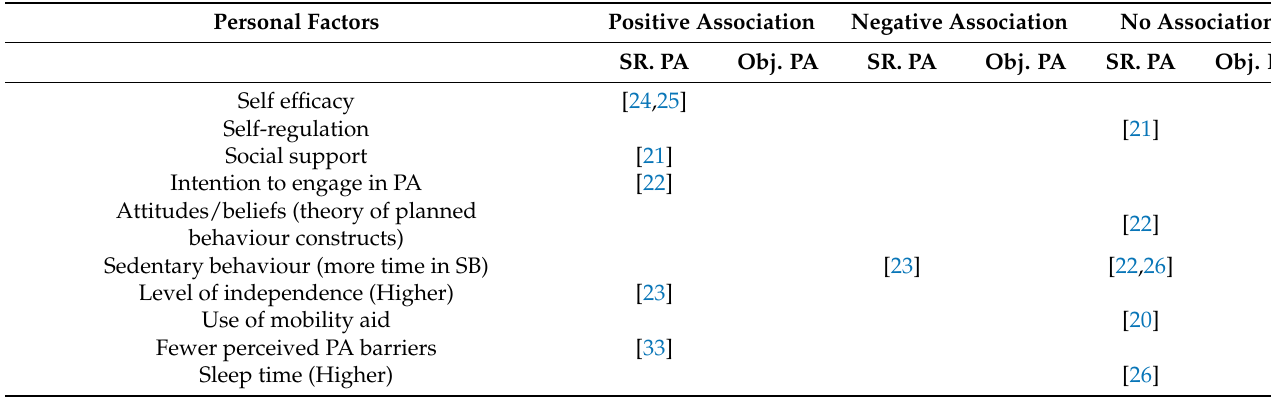
Table 7. Modifiable personal correlates of MVPA.